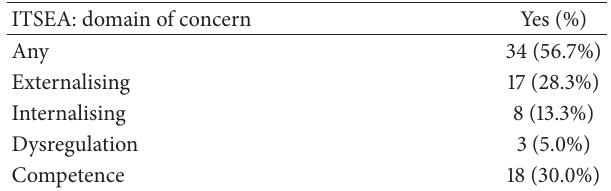
Table 2: Children with domain of concern on ITSEA ( 𝑛 = 60